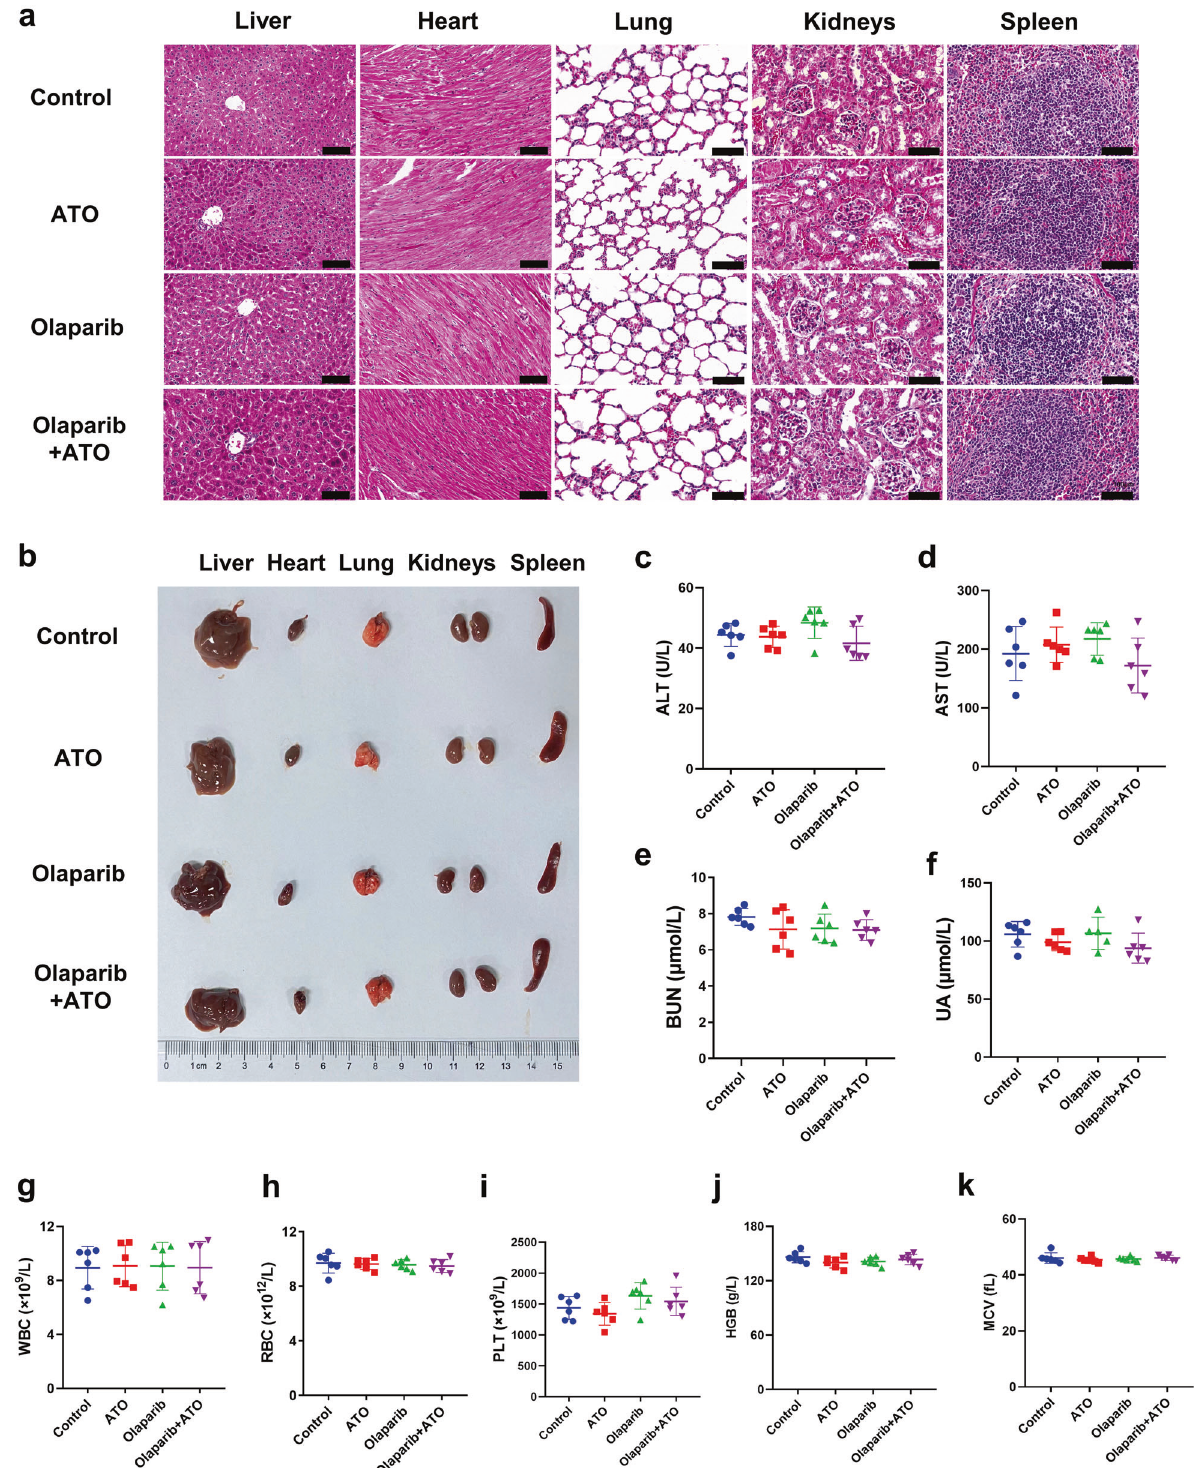
Fig. 7 Preliminary biosafety evaluations of combination treatment of olaparib and ATO in mice model. a , b HE staining images and representative images of major organs (heart, liver, spleen, lung, and kidney) from mice after different treatments (Scale bar = 100 μ m). c – k The blood biochemistry and hematology assays of mice treated with indicated agents at the endpoint. The testing parameters included examinations of alanine aminotransferase (ALT), aspartate aminotransferase (AST), blood urea nitrogen (BUN), uric acid (UA), red blood cell (RBC) counts, white blood cell (WBC) counts, platelets (PLT), hemoglobin (HGB), hematocrit (HCT), and mean corpuscular volume (MCV).